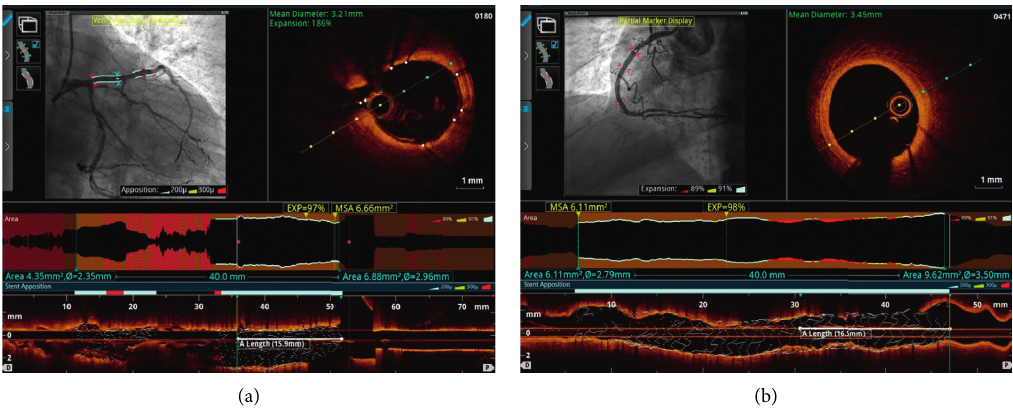
Figure 4: Accuracy of stents positioned with the aid of the SPAS device. Optical coherence tomography (OCT) performed following stent implantation shows (a) full correspondence between planned and actual stent position and (b) a 1mm deviation (2.5% of stent length) from planned and actual stent